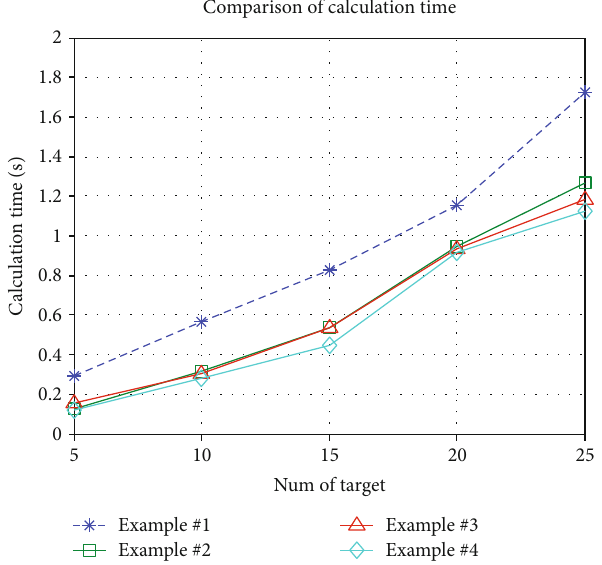
Figure 12: The comparison of calculation time obtained by two types of